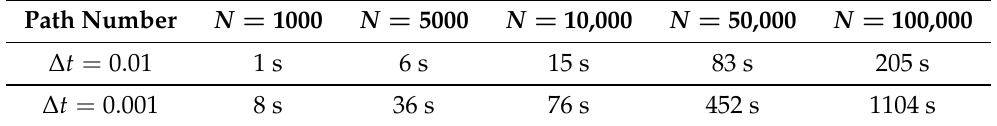
Table 4. The CPU time of the DNN method with alternative formulae ( D E = 200, D I = 30). Training Times N = 1000 N = 5000 N = 10,000 N = 50,000 N = 100,000 Parameter 1